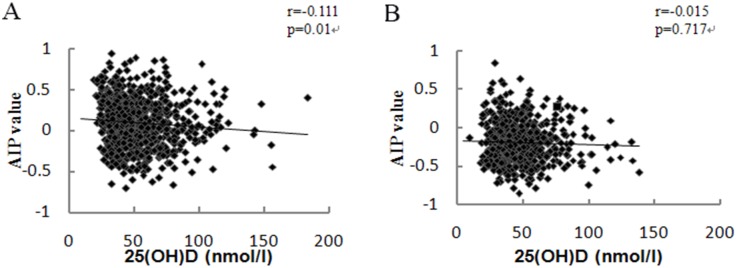
The correlation between 25(OH)D and AIP.Scatter plot showing the relations between serum 25(OH)D concentrations and AIP in men (A) and women (B).